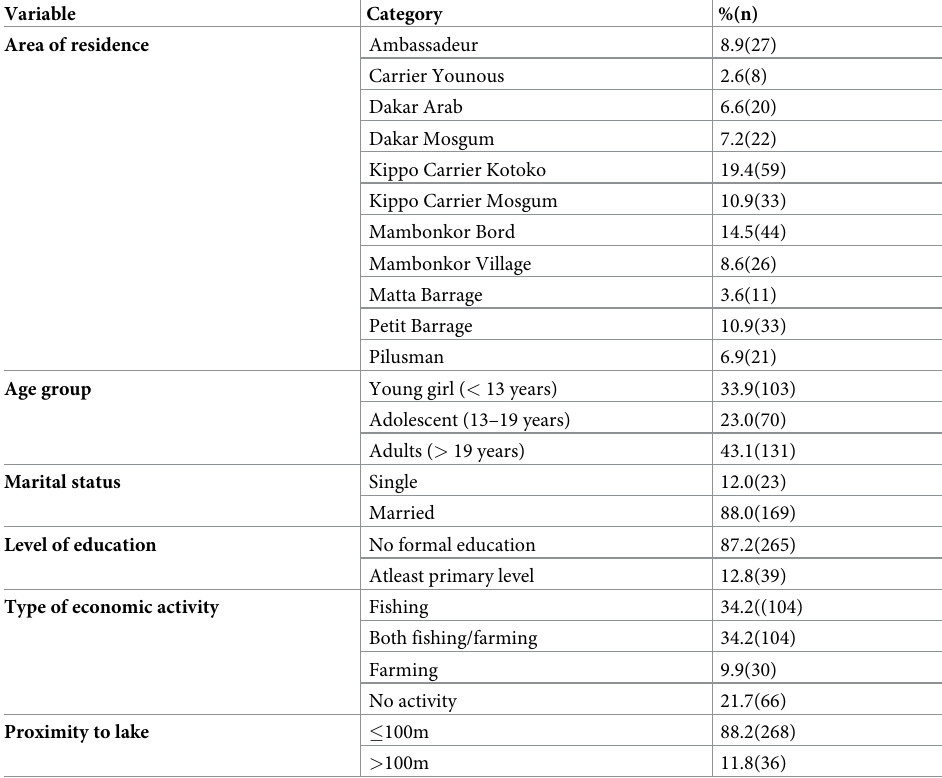
Table 2. Participant